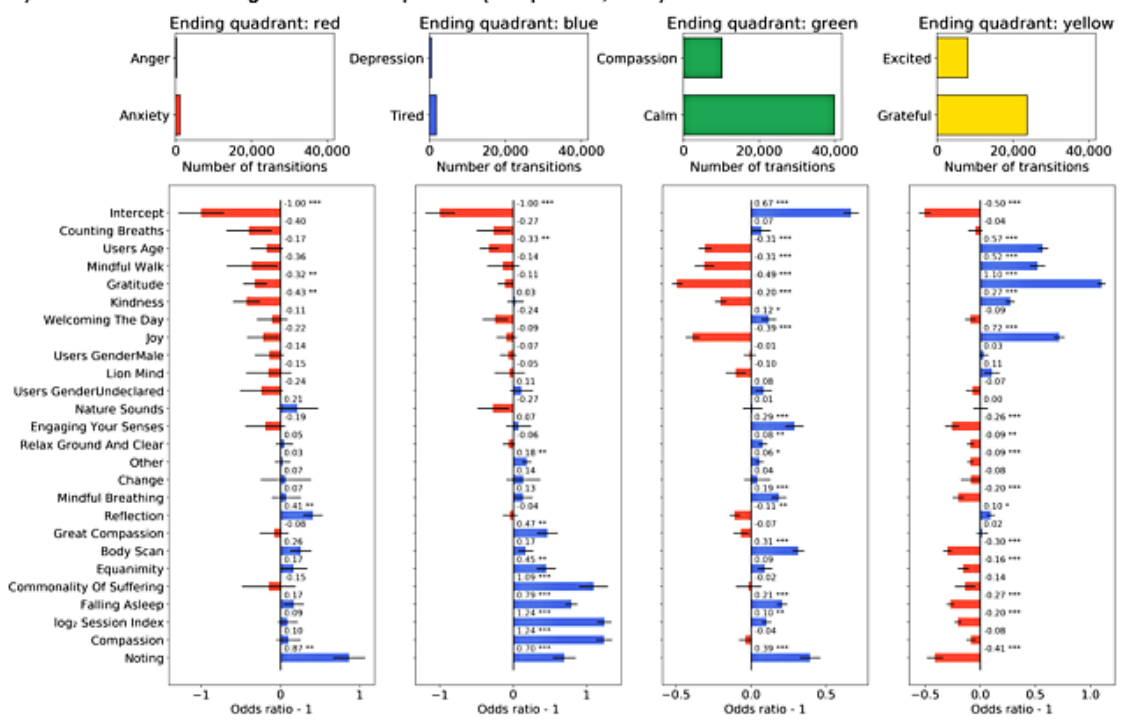
Figure 7. Transitions starting in Green Yale Mood Meter (YMM) quadrant model odds ratios. Sixteen GLM model fixed effect estimated odd ratios and P values (<.001***, <.01**, and <.05*) for mindfulness and meditation activities, gender, session index, and y-intercept split by starting YMM quadrant. Blue bars indicate increased propensity to make a transition, whereas red bars indicate decreased probability of making the transition.